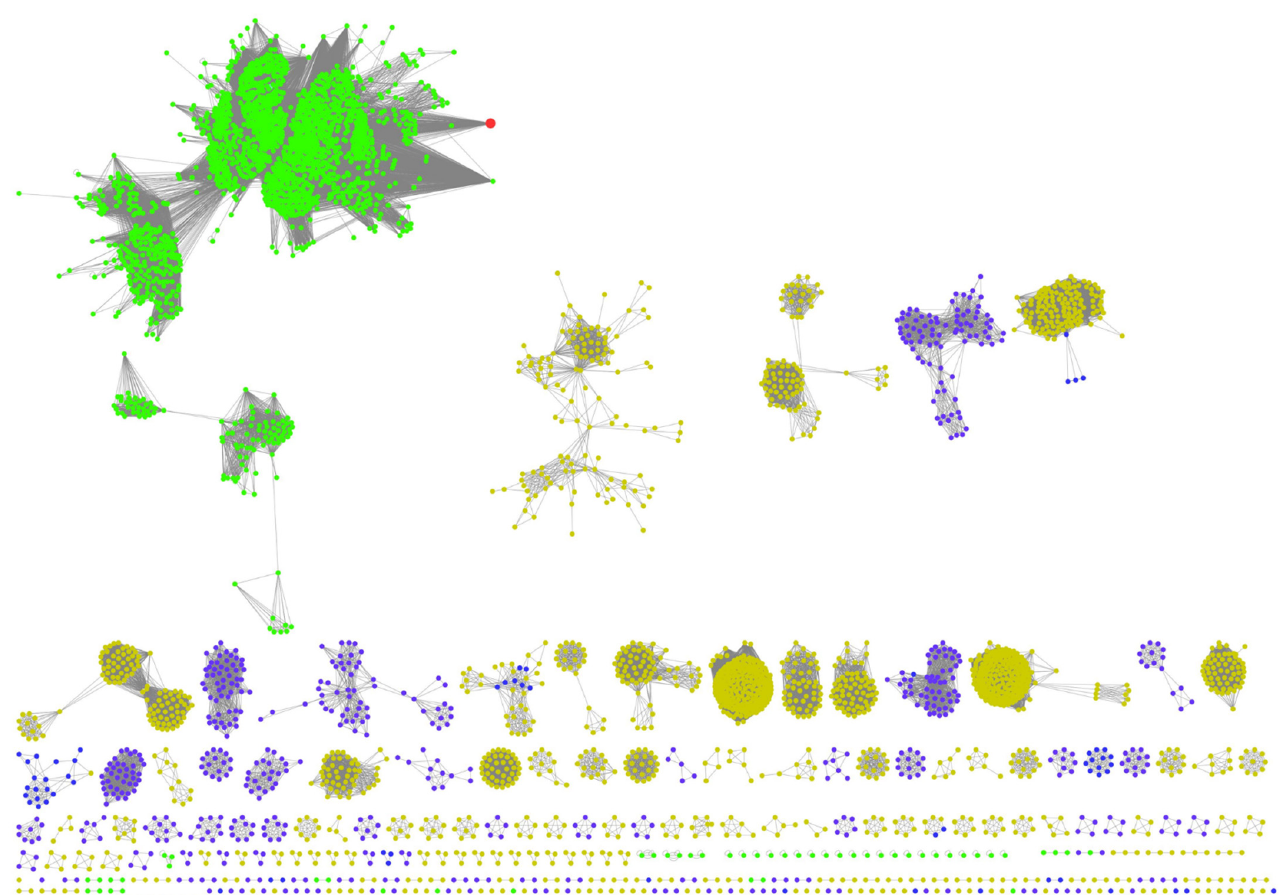
Figure 14. SSN showing putative THCA synthase orthologs with at least 40% sequence identity. Green nodes represent sequences from plant species, yellow from bacterial species, purple from all other Eukaryota species. THCA synthase sequence is denoted by a red node.